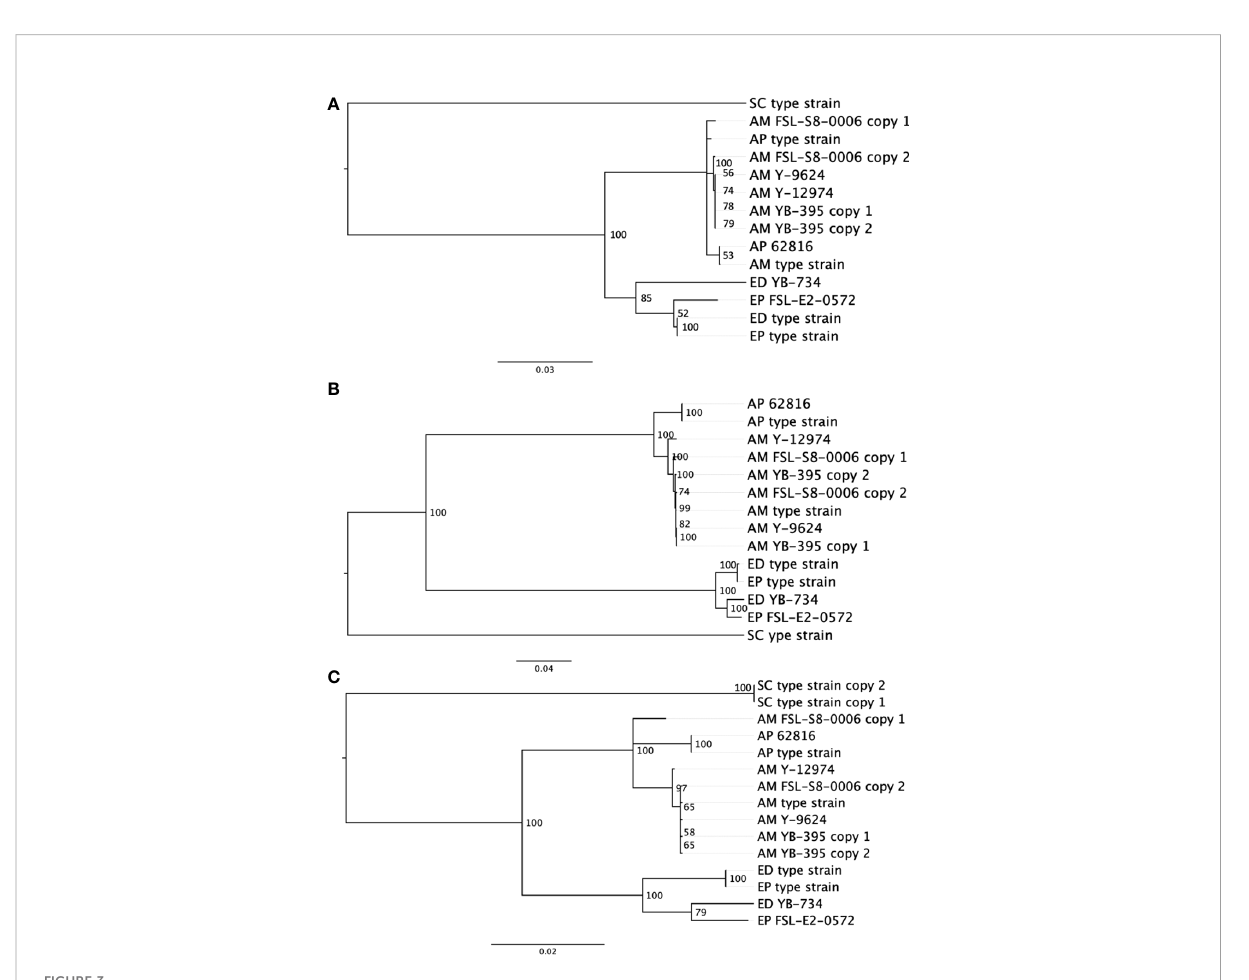
FIGURE 3 Neighbor-joining phylogenies based on protein sequences for (A) beta tubulin, (B) RNA polymerase II RPB2, and (C) translation elongation factor TEF1 in eight black yeast strains and fi ve other black yeast type strains (AP, A. pullulans ; AM, A. melanogenum ; ED, E. dermatitidis ; EP, E. phaeomuriformis ; SC, Saccharomyces cerevisiae